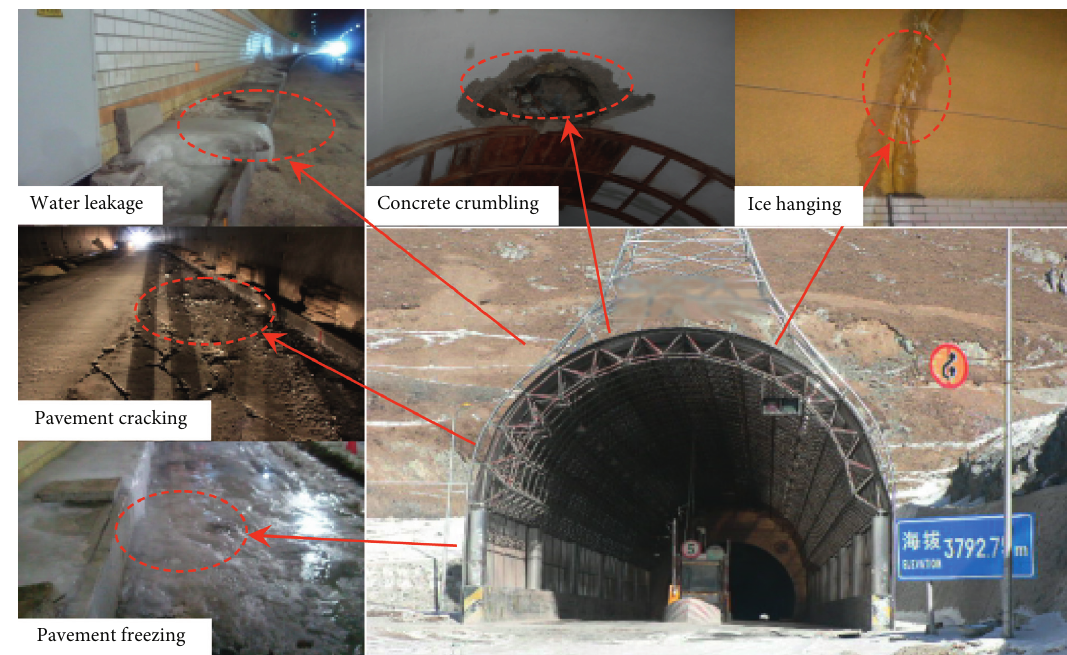
Figure 1: Frost damage in cold-region